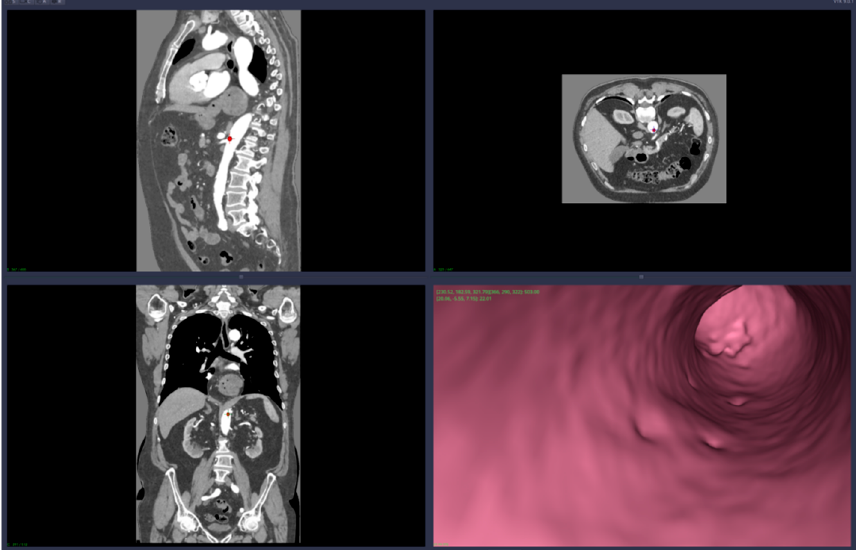
Figure 6. Virtual angiography—exit from the mesenteric artery into the aorta (direction is opposite to the blood flow).